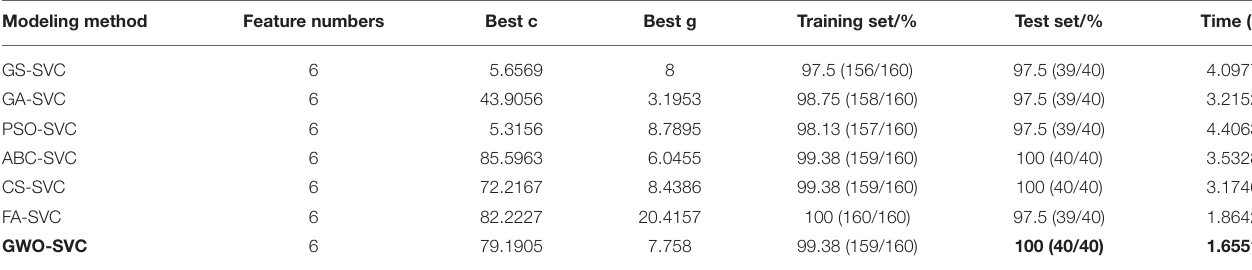
TABLE 5 | Classification results of different optimization